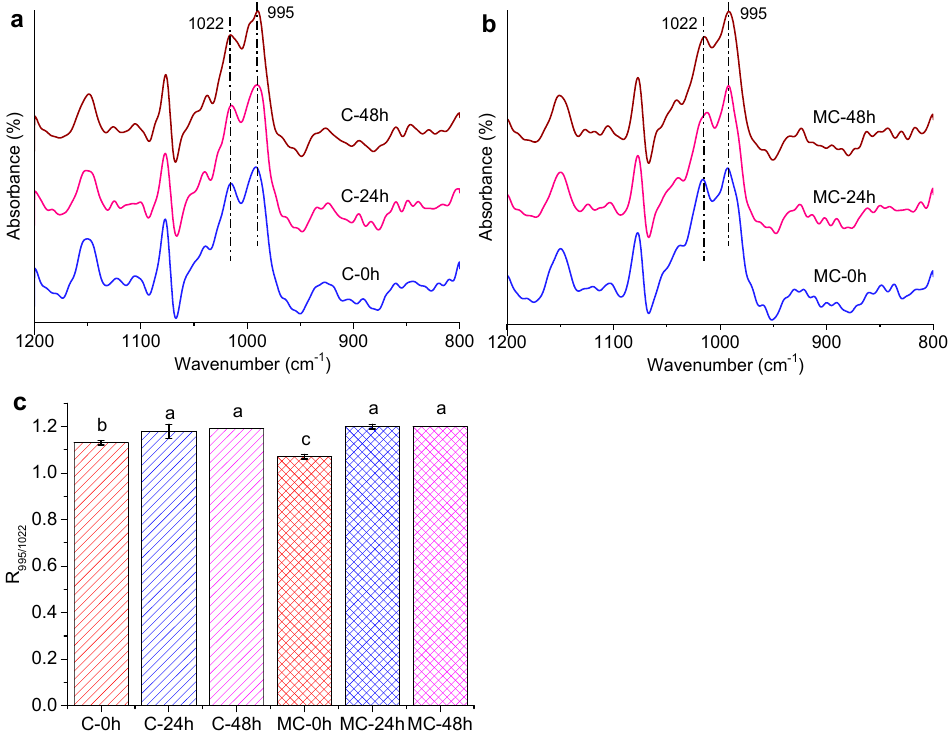
Figure 4. ATR-FTIR patterns: ( a ) conventional cooking; ( b ) microwave cooking; and ( c ) the intensity ratio ( R 995/1022 ) values of conventionally (C) and microwave-cooked (MC) starches with different storage times (0, 24, or 48 h). The different lowercase letters above the data bars in ( c ) indicate a significant difference at p < 0.05.